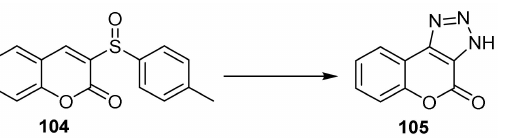
NaN 3 , DMF, 95 ◦ C, 5 h, N 2 , 84%